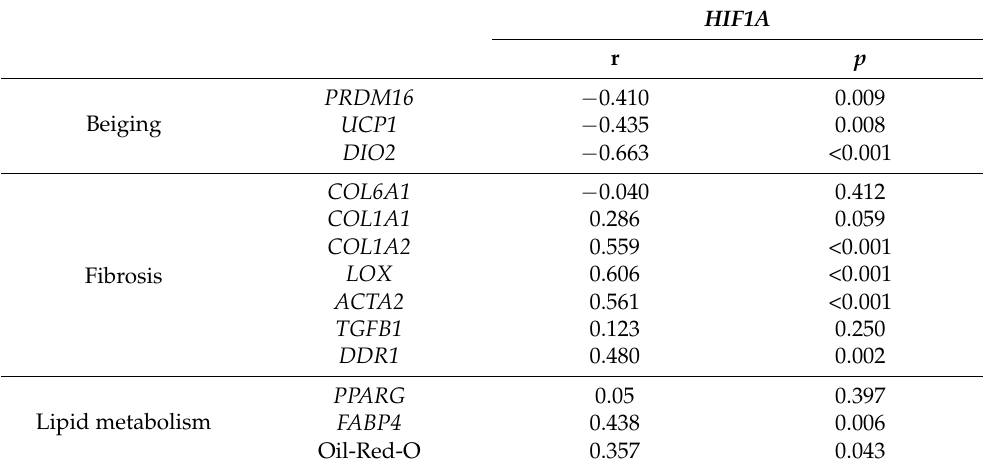
Table 2. Correlations (Pearson’s test) between HIF1A and beiging, fibrosis and lipid accumulation in vitro. Correlation between HIF1A gene expression and beiging-, fibrosis-, and lipid-related gene expression or lipid accumulation in INSTI-treated beige adipocytes. Correlations were determined using PCR data obtained using ASCs ( n =